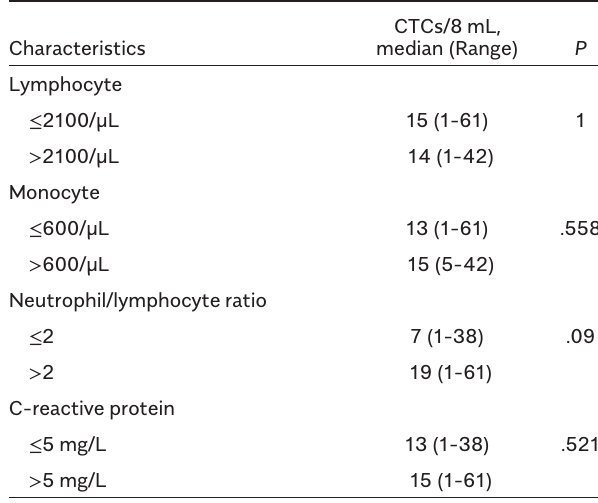
Table 2. The Median Number of CTCs According to Clinicopathological Characteristics of Patients ( Continued